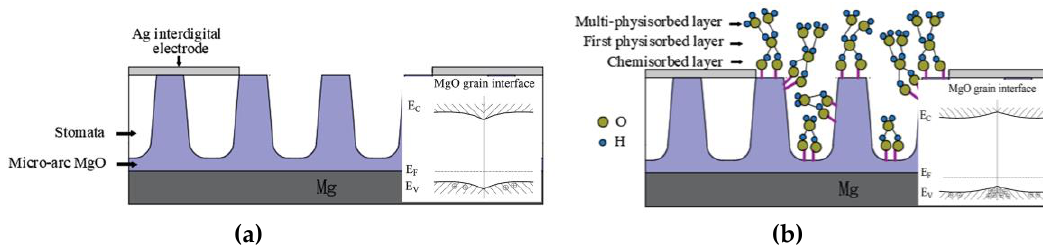
Figure 9. Schematic diagram of the mechanism of micro-arc MgO film surface ( a ) before water molecule adsorption and ( b ) after water molecule adsorption. The illustration in (a) is the surface energy state of the film before the adsorption of water molecules, and the illustration in ( b ) is the surface energy state of the film after the adsorption of water molecules.